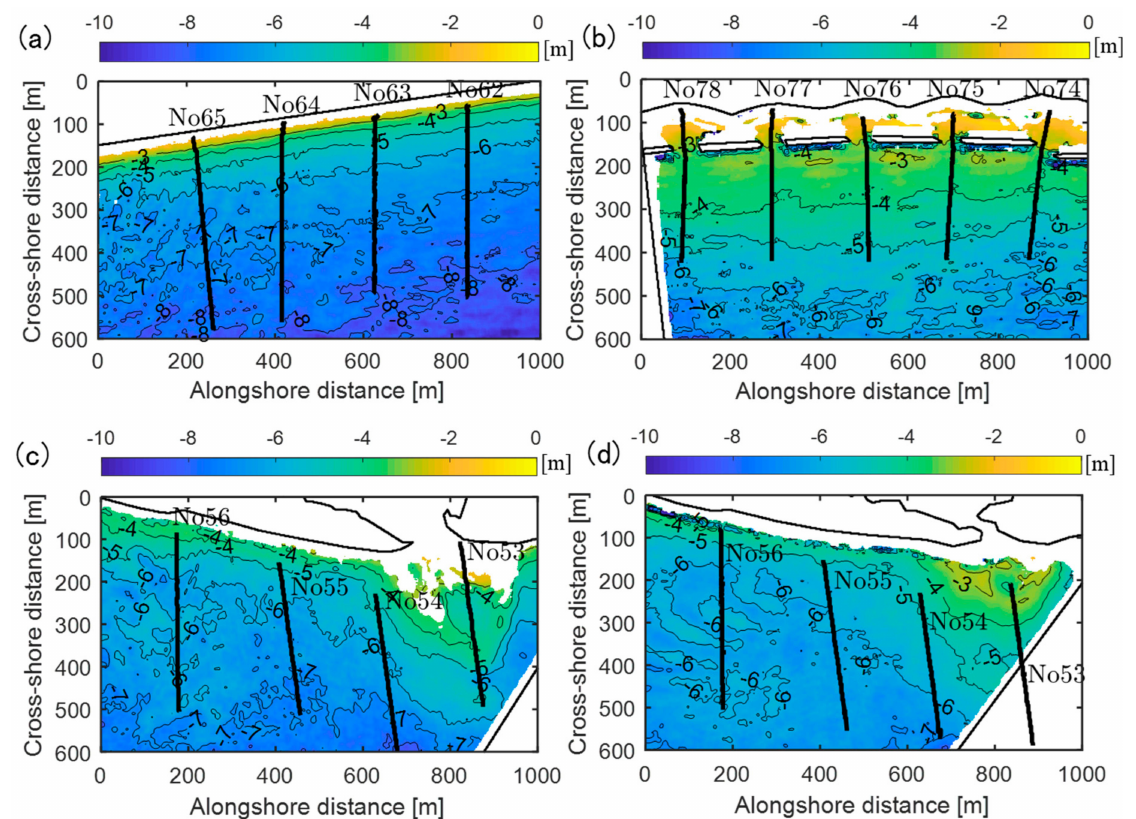
Figure 9. Map of estimated seabed levels. ( a ) Case 1, ( b ) Case 2, ( c ) Case 3, and ( d ) Case